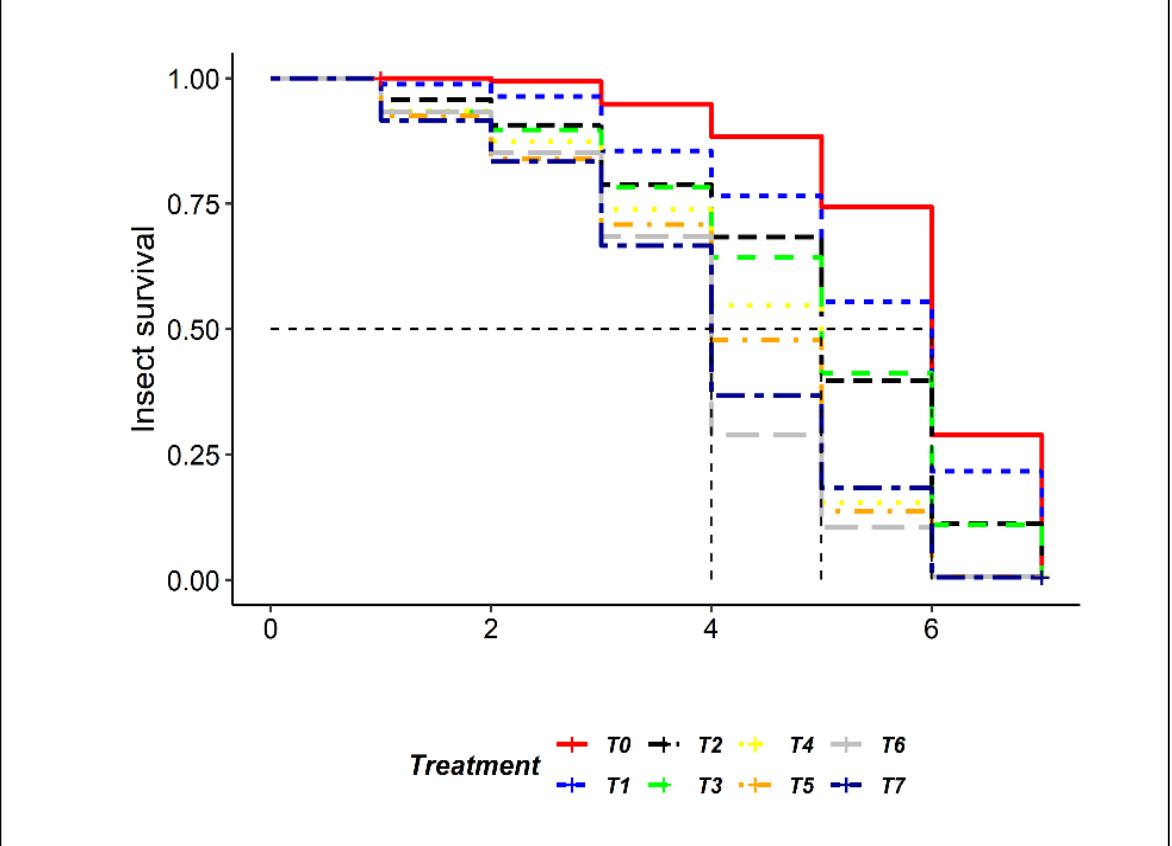
Figure 1 : Survival curves of insects according to different treatments of C. aconitifolius